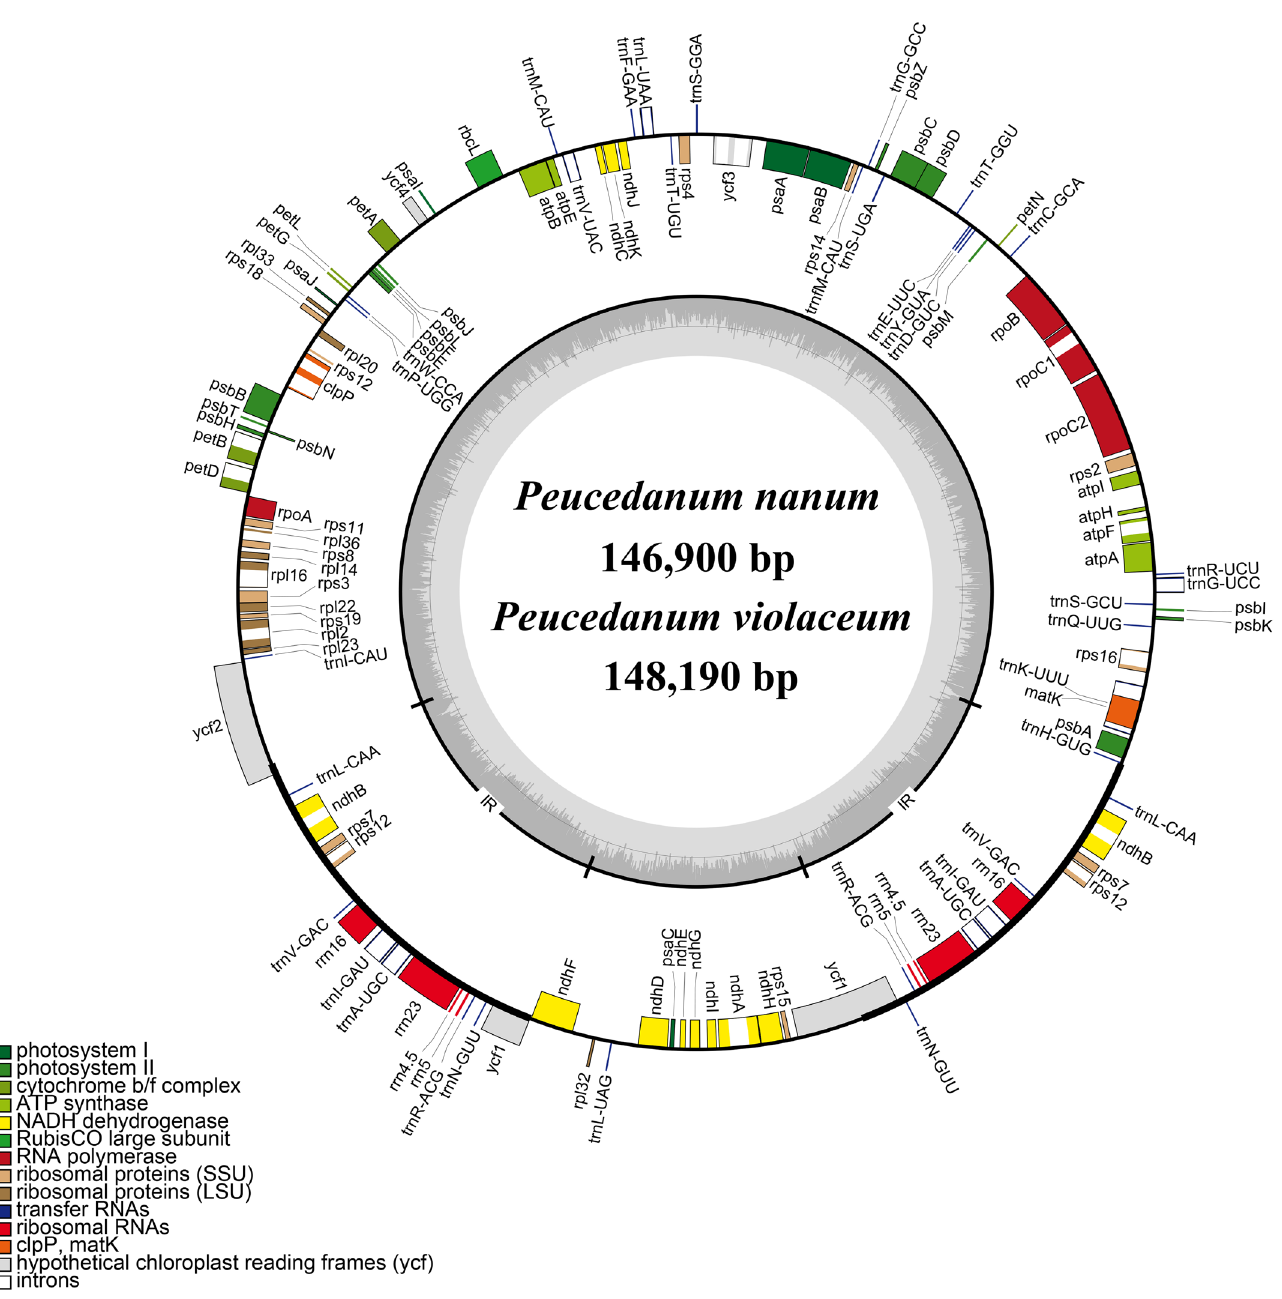
Figure 2. Whole plastome map of Peucedanum nanum and P. violaceum . Genes shown outside of the circle were transcribed counterclockwise, while those presented inside were transcribed clockwise. The dark gray area of the inner circle shows the GC content of the